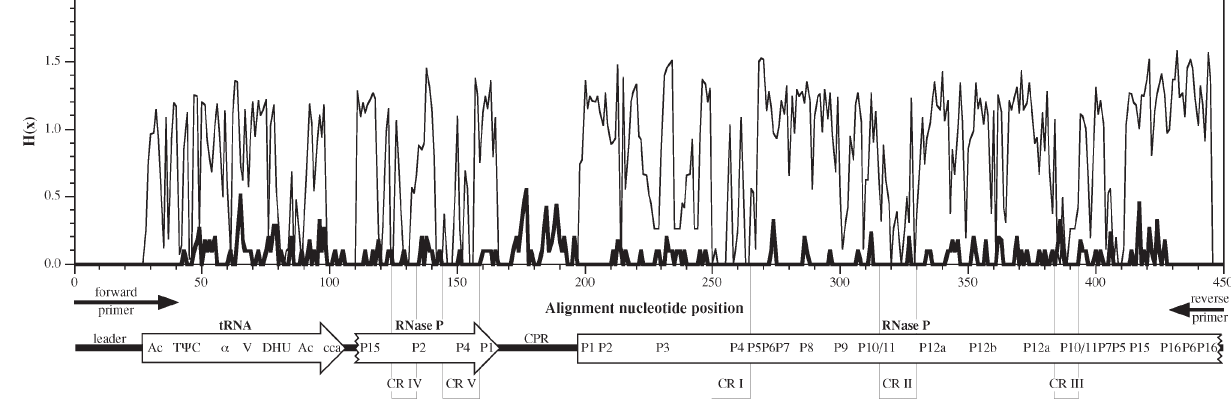
Figure 2. Sequence variation in the selected RNAs compared with naturally occurring variation. The linear sequence of the cpTP RNA, shown here diagrammaticallyand labeled as in Figure 1, is plottedagainst sequence variationexpressed as H(x); H is an entropy coefficientfor each posi- tion x in which H = – Σ b f b ln b where b is in set (A, G, U, C, –) expressed in bits of information (Chiu and Kolodziejczak 1991). The coefficient H varies from zero (absolutely conserved) to 1.61 (completely randomized). Observed variation in the 50 sequenced active selection products is shown as a heavy line; naturally occurring variation among the 40 available archaeal RNase P RNAs in the RNase P Database (http://jwbrown. mbio.ncsu.edu/RNaseP/) and 155 archaeal tRNAs in the tRNA Database (http://www.bayreuth.de/departments/biochemie/sprinzl/index.html) is shown as a light